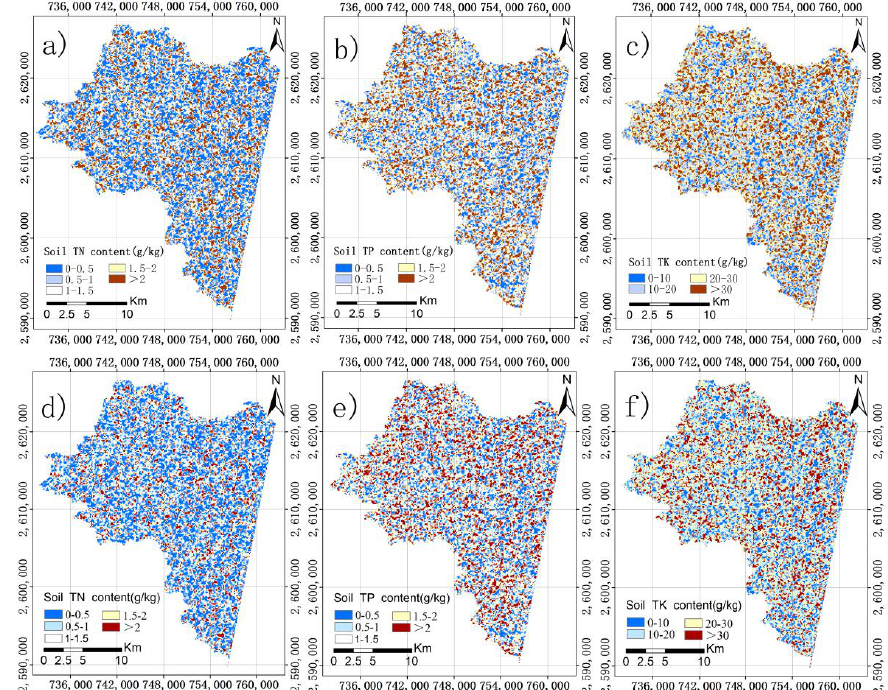
Figure 11. Spatial distributions of soil nutrient contents for the testing area: ( a ) and ( d ) TN maps acquired from the original optimal spectral variables (OOSV) and the soil component optimal spectral variables (SCOSV); ( b ) and ( e )TP map acquired from the OOSV and SCOSV; and ( c ) and ( f ) TK maps obtained from the OOSV and SCOSV. Table 4. Comparison of measured and predicted contents of TN, TP, and TK obtained using the original optimal spectral variables (OOSV) based GA-BPNN model and the soil component optimal spectral variables (SCOSV) based GA-BPNN model based on the 33 validation sample plots (St. Dev: standard deviation; R 2 : coefficient of determination; RRMSE: relative root mean square error).